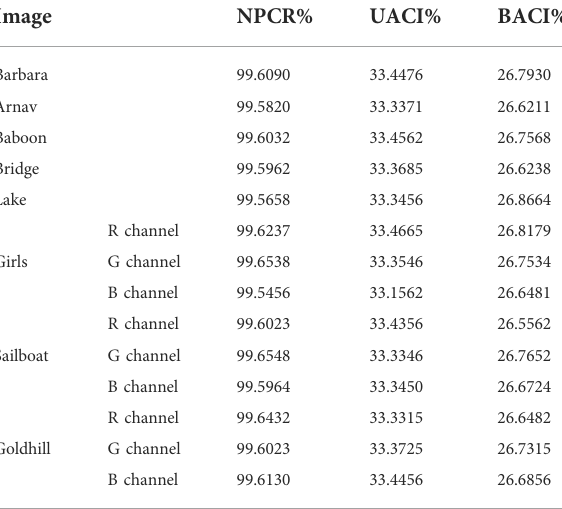
TABLE 5 NPCR, UACI and